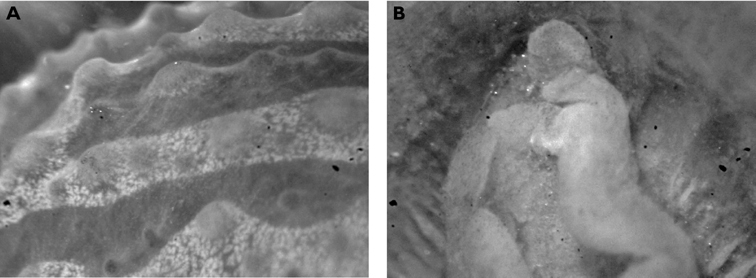
Phyllidia exquisita, 11 mm pres. specimen A dorsal view showing granular white pigmentation and spiculose black areas B ventral view of propodium, head, and oral tentacles (left oral tentacle folded over).